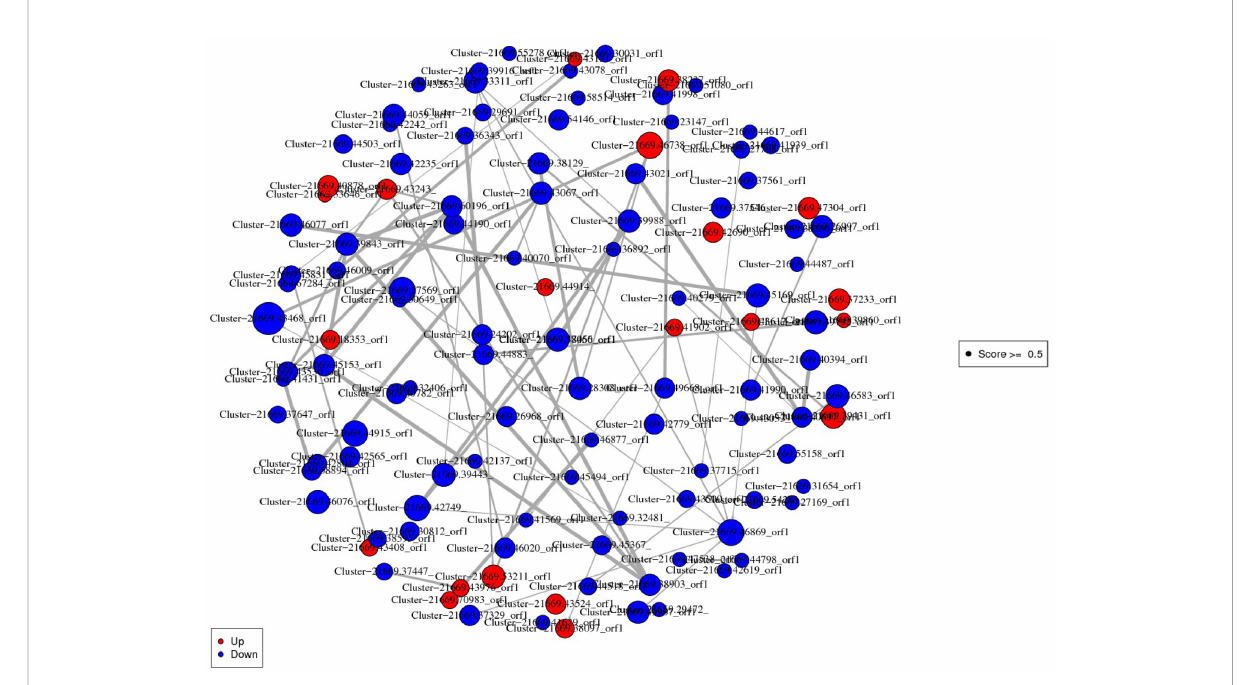
FIGURE 4 Interaction network diagram of DEPs. Red spots represent upregulated DEGs. Green spots indicate downregulated